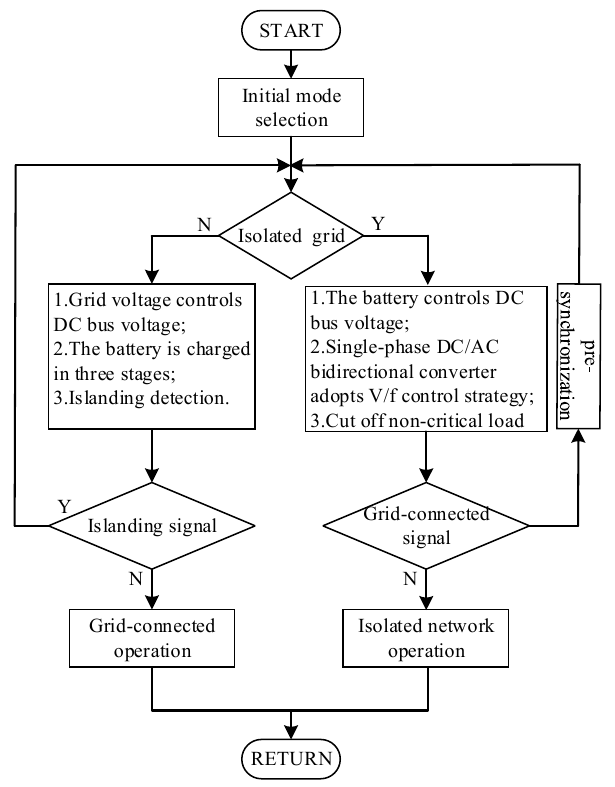
Figure 16. Flow chart of overall operation control of SPEER.